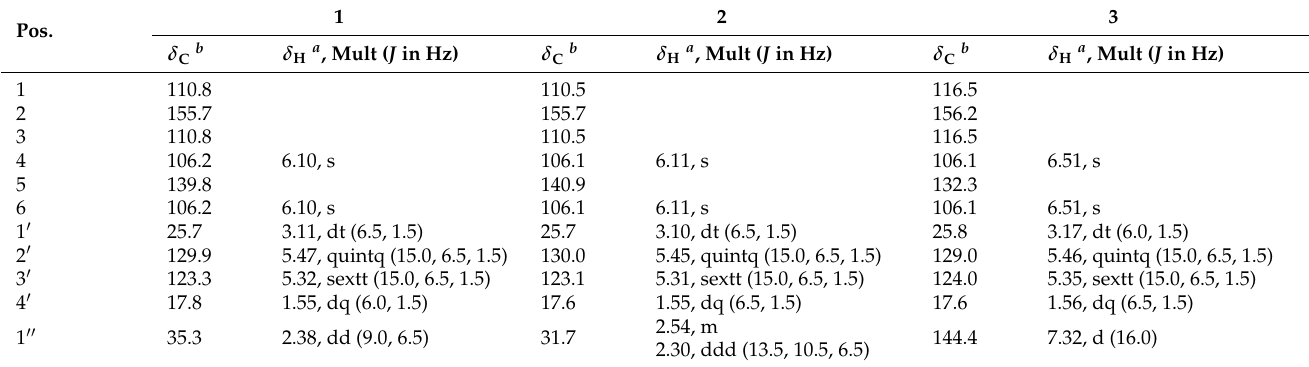
Table 1. Spectrum data of three new